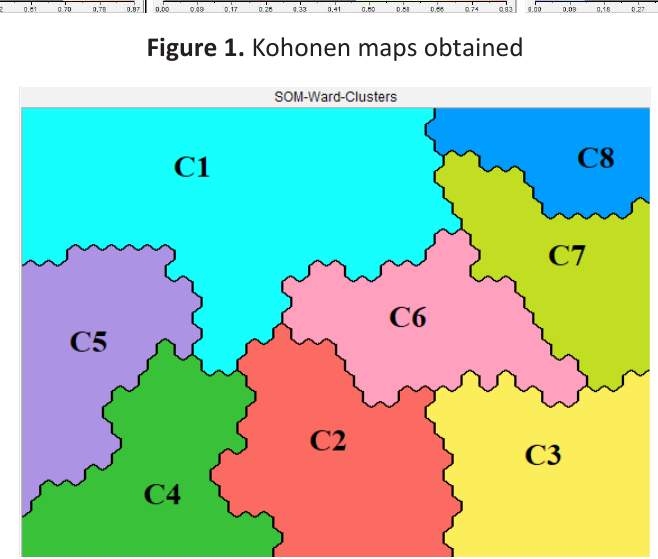
Figure 2. General Kohonen